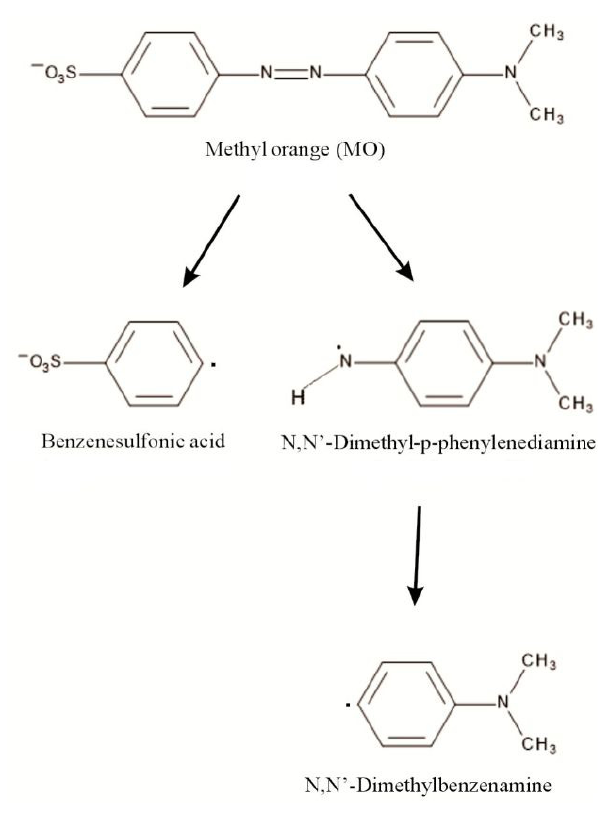
Figure 10. Degradation scheme of methyl orange